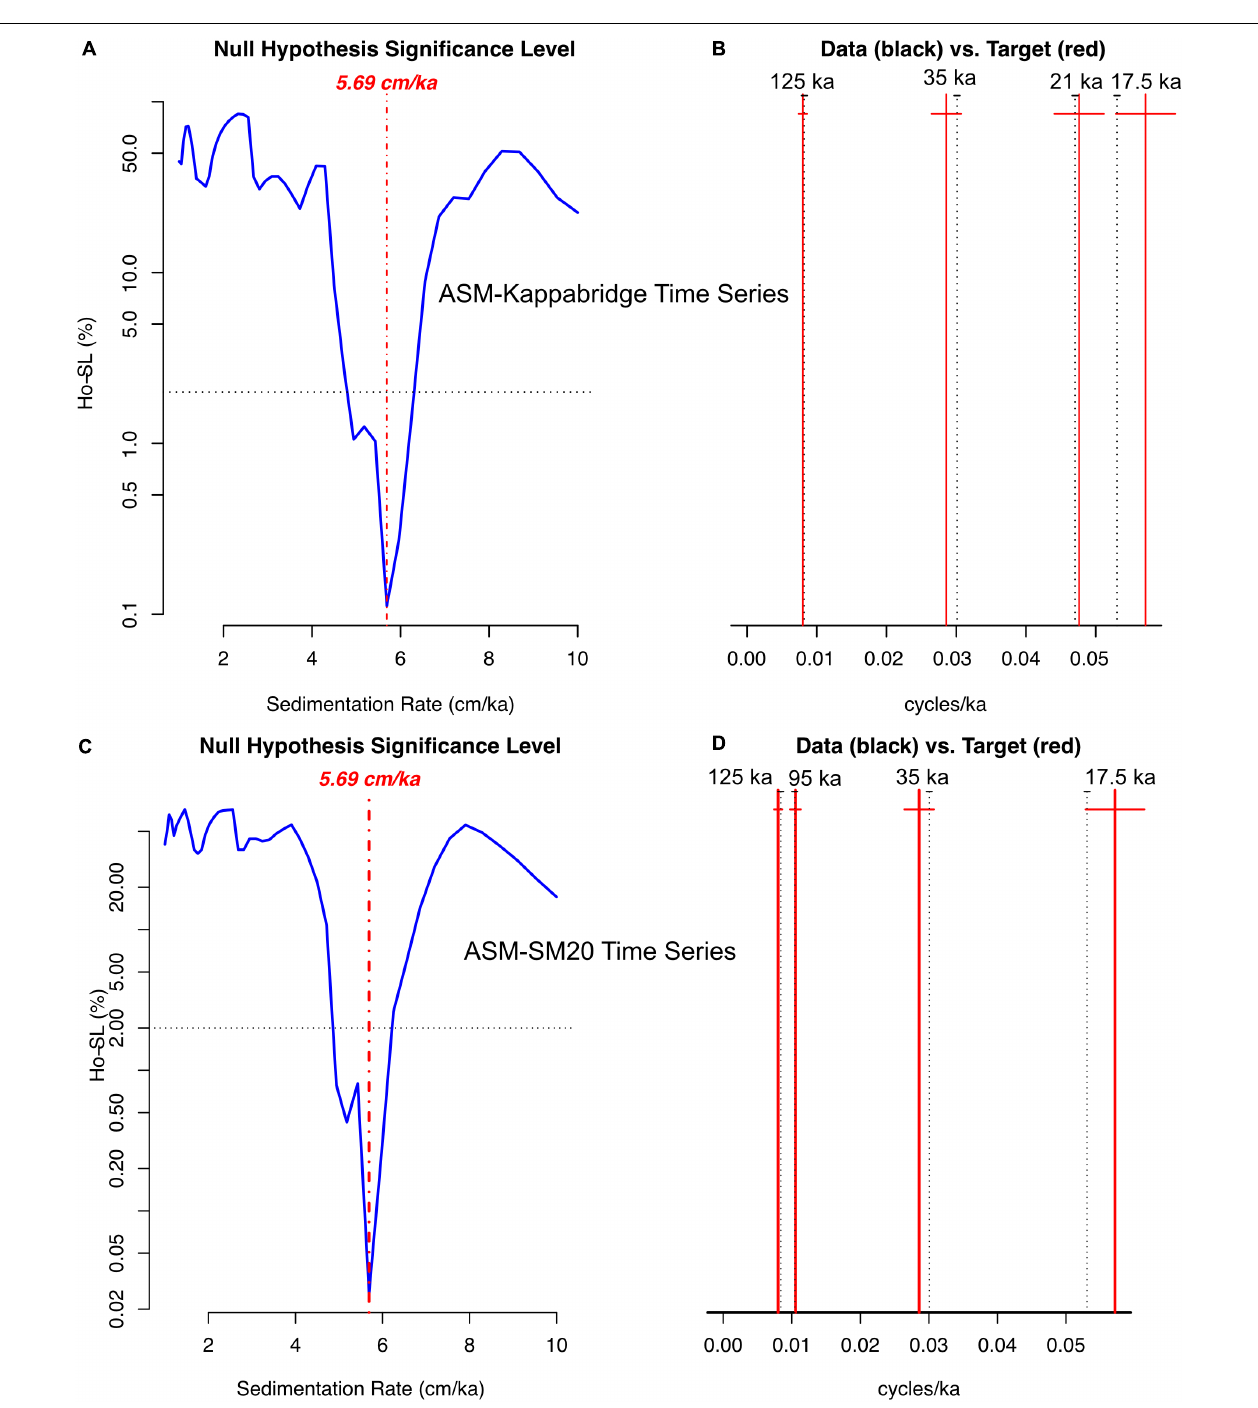
FIGURE 6 | Average spectral misfit (ASM; Meyers and Sageman, 2007) results for the Kappabridge (A) and SM-20 (B) spectral peaks targeted to eccentricity, obliquity, and precession at 330 Ma. The significant fit for the two different time series indicates an identical sediment accumulation rate of 5.69 cm/ka. In panels (C) and (D) , the dotted black lines are the data and the red solid lines are the target Milankovitch